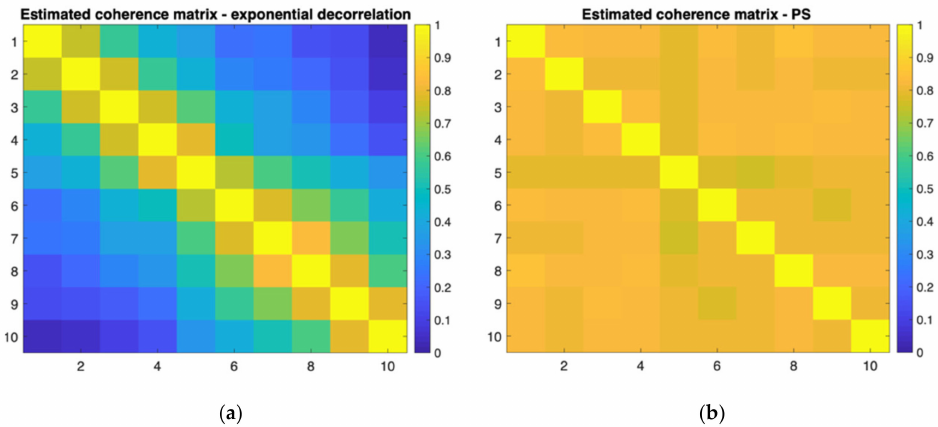
Figure 1. Estimated coherence matrix: ( a ) Exponential decorrelation characterized by a decay time of 24 days. ( b ) PS with constant coherence of